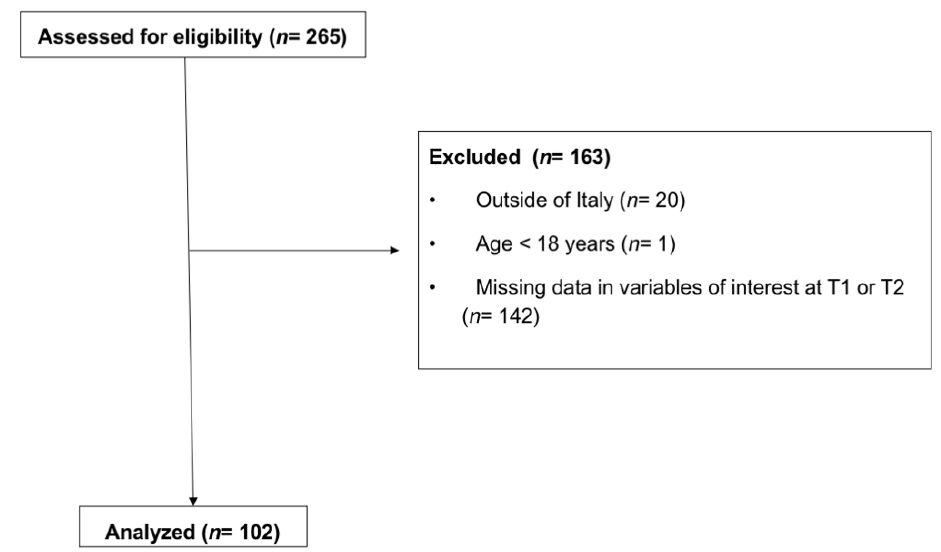
Figure 1. Description of the participants’